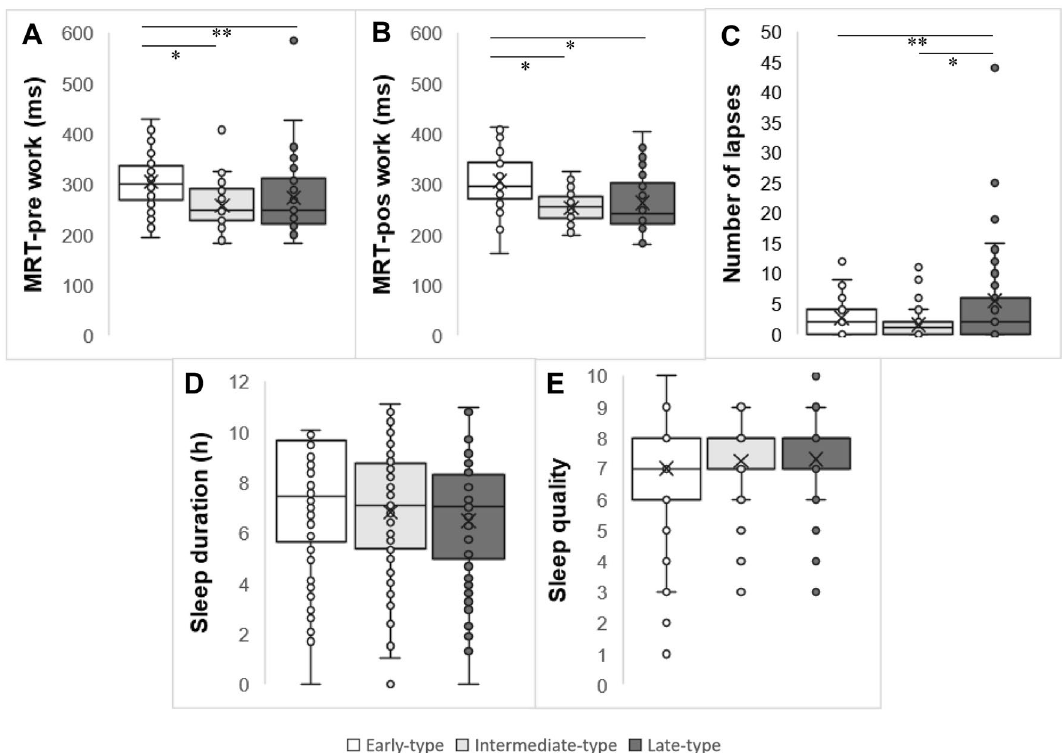
Figure 3. Box plots of the distribution of MRT, number of lapses in attention and sleep duration according chronotypes throughout a complete shift rotation. ( A ) MRT pre work according chronotypes. ( B ) MRT post work according chronotypes. ( C ) Sum of lapses during the shift. ( D ) Sleep duration according chronotypes. ( E ) Sleep quality according chronotypes. Data correspond to mean ± standard error ( n = 30). *Statistical differences, p < 0.001. **Statistical differences, p < 0.05. GLM adjusted for age, BMI, years working in shifts and presence of children at